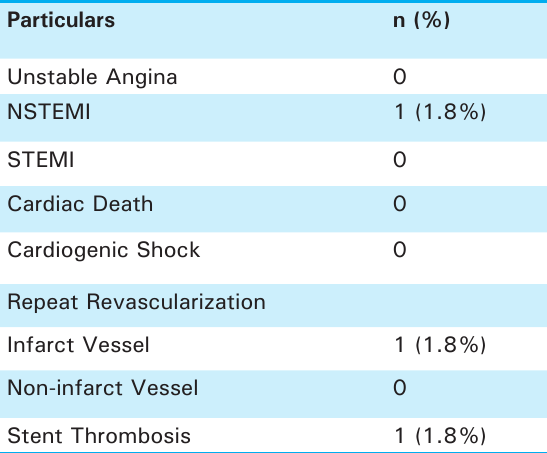
table 3. MAcE at three Months Follow